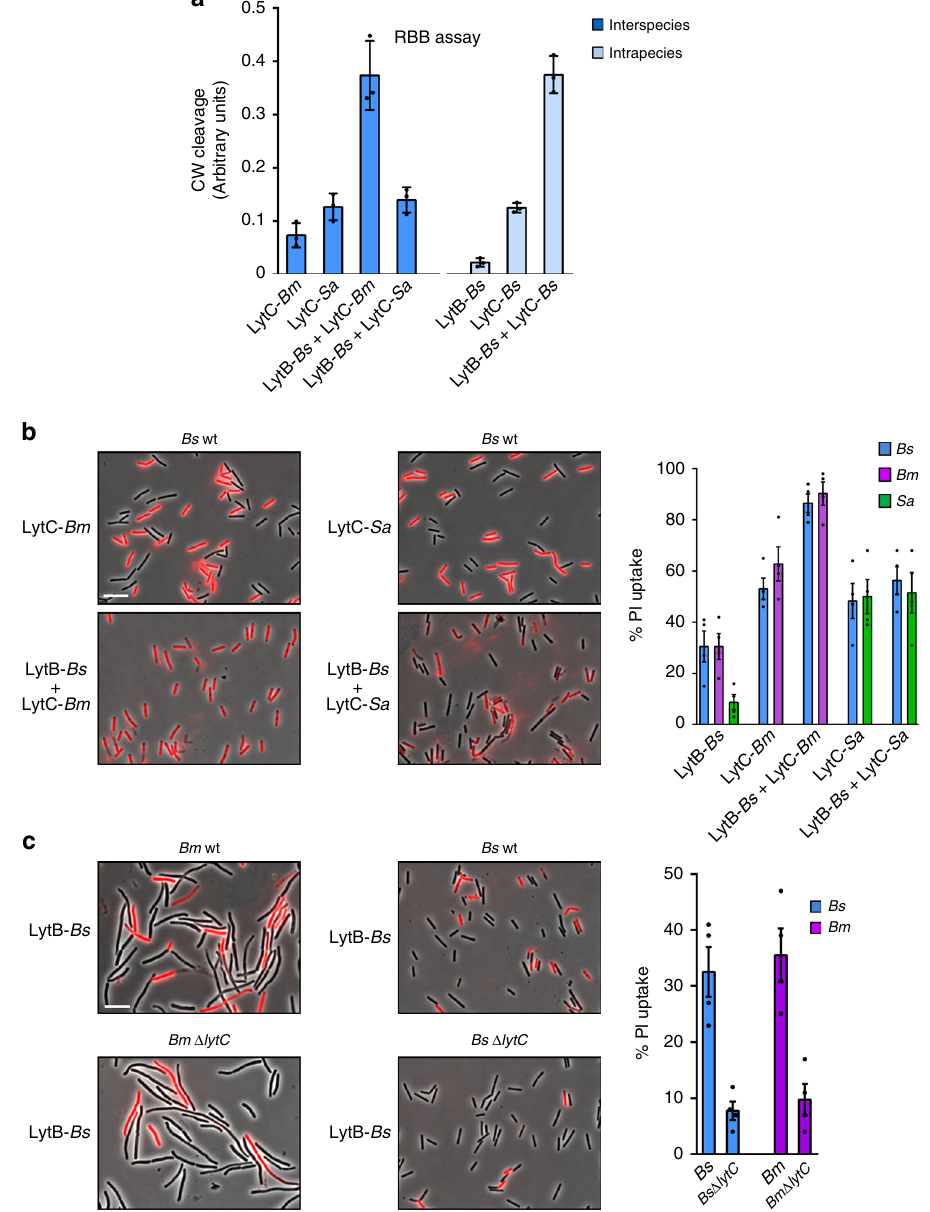
Fig. 6 Interspecies LytB and LytC can pair to enhance CW degradation. a CW was isolated from Bs (PY79), labeled with RBB and mixed with puri fi ed proteins in the various indicated combinations. The cleaved products were separated by centrifugation and absorbance of supernatant was measured at 595 nm. Shown are mean ± SEM of at least three independent experiments. b Bs wt (PY79) cells were incubated for 10 min with puri fi ed LytB- Bs with or without LytC from Bm or LytC from Sa , stained with PI, and visualized by fl uorescence microscopy. Shown are overlay images of phase contrast (gray) and fl uorescence from PI staining (red). Scale bar represents 5 μ m. Graph presents quantitation of PI uptake by the indicated cells following the above treatments. Shown is the percentage of PI-labeled cells and mean ± SEM of at least three independent experiments ( n cells = 400). c Bm wt (OS2) or Δ lytC (ABm2) and Bs wt (PY79) or Bs Δ lytC (AB3) strains were incubated for 10 min with LytB- Bs , stained with PI and visualized by fl uorescence microscopy. Shown are overlay images of phase contrast (gray) and fl uorescence from PI staining (red). Scale bar represents 5 μ m. Graph presents quantitation of PI uptake by the indicated cells following the above treatments. Shown is the percentage of PI-labeled cells and mean ± SEM of at least three independent experiments ( n cells = 400). Source data are provided as a Source Data fi Methods Bacterial strains and general methods . Bs are derivatives of the wild-type strain PY79, Bm is a wild-type soil isolate (OS2) and its derivatives, Sa is MRSA strain and Vc is O1 El Tor N16961 strain. Bacterial strains and plasmids are listed in Supplementary Data 1, and primers are listed in Supplementary Data 2. All general methods were carried out as described previously 42 . Transformation into Bm OS2 cells was conducted as described 43 . In brief, Bm OS2 cells were grown up to 1.0 OD 600 , washed with electroporation buffer (25% PEG 6000 and 0.1M sorbitol) and